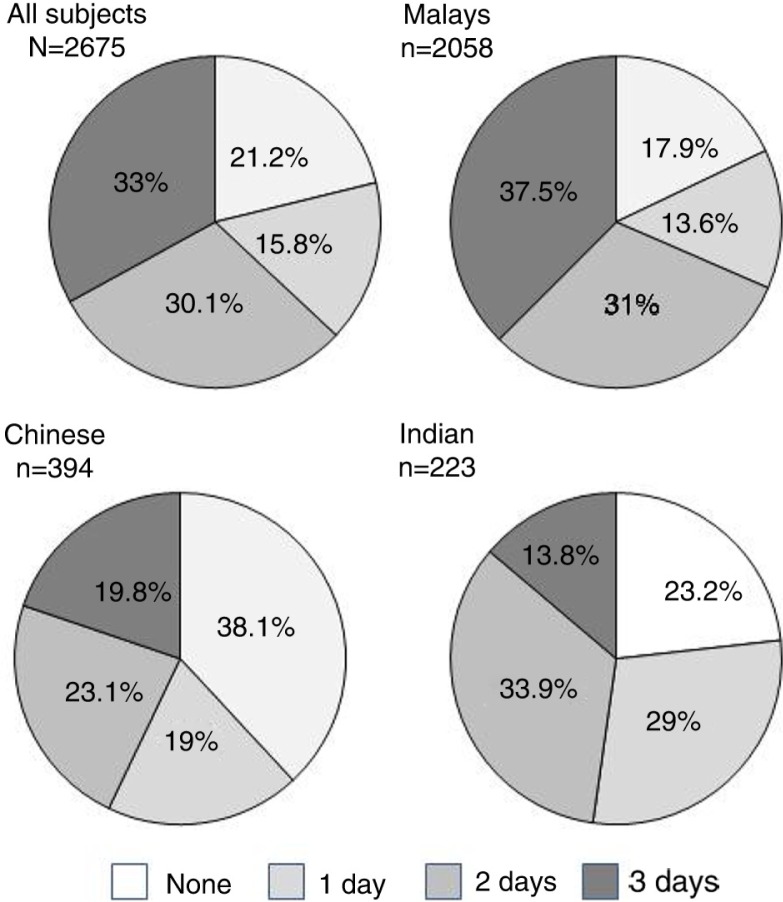
Number of days (in percentages) in which fish was consumed among the adults of different ethnicities from Peninsular Malaysia, using 3-day records of food consumption as a survey method.